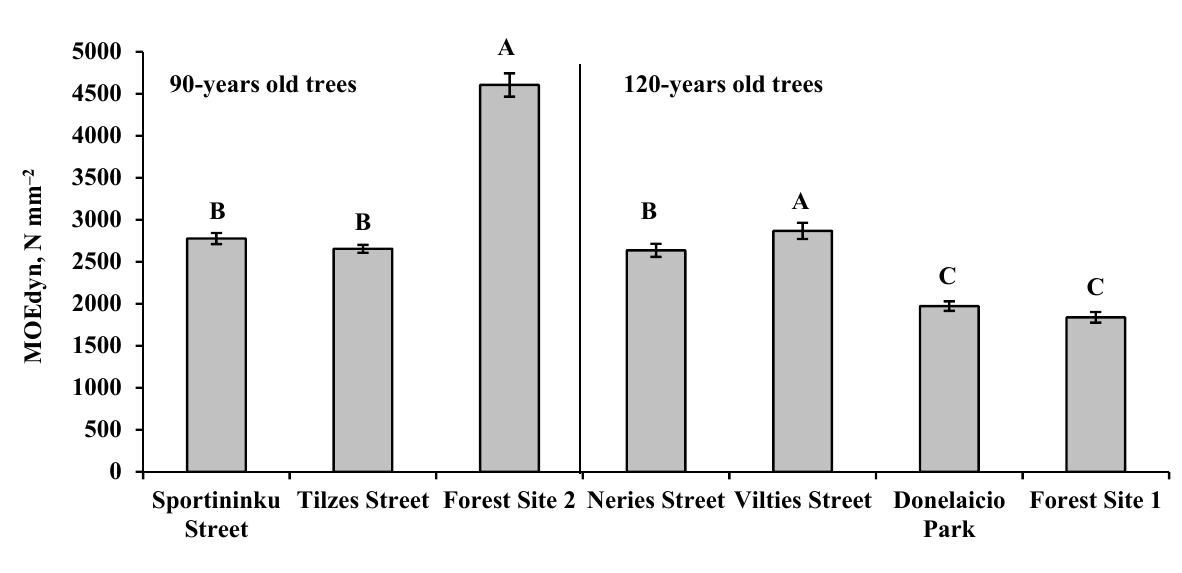
Figure 4. Mean values of top-end diameter (D top-end , cm) ( A ), and dynamic modulus of elasticity (MOEdyn, N mm − 2 ) ( B ) of small-leaved lime trees from different sites. Bars show the standard error of the mean. Different capital letters at the top of the columns show statistically significant differences between the sites within each tree age group (separately for 90- and 120-year old trees) at p < 0.05.